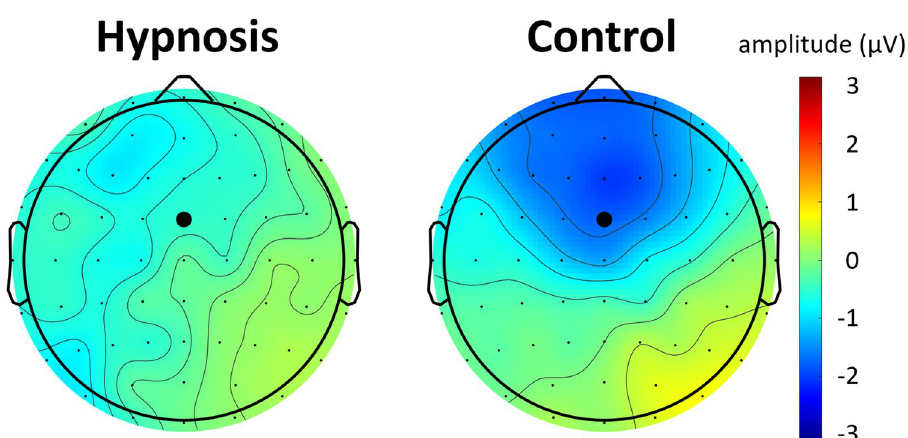
Figure 7. Topographical plot of the delay reward positivity averaged over reward magnitude during the delay reward positivity time window. Participants showed significantly smaller reward positivity amplitudes in the hypnosis condition compared to the control condition. Amplitudes were maximal over frontocentral electrode sites. The channel FCz is marked by a bigger black